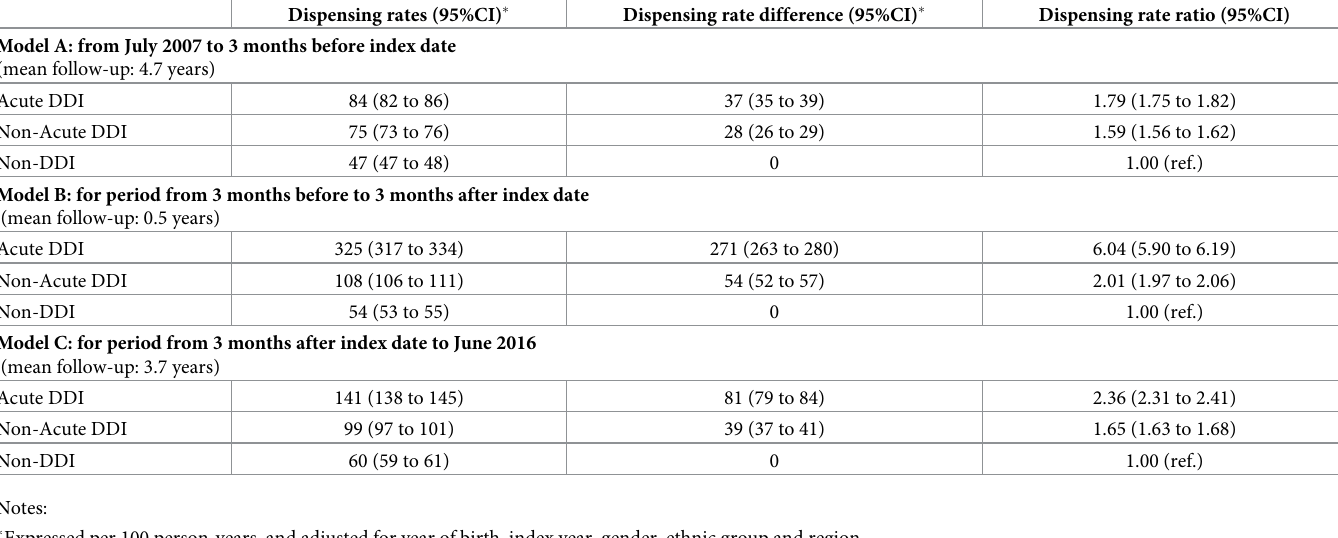
Table 2. Dispensing rates per 100 person-years, dispensing rate difference and dispensing rate ratio of antibiotics in the periods A) before B) about, and C) after index